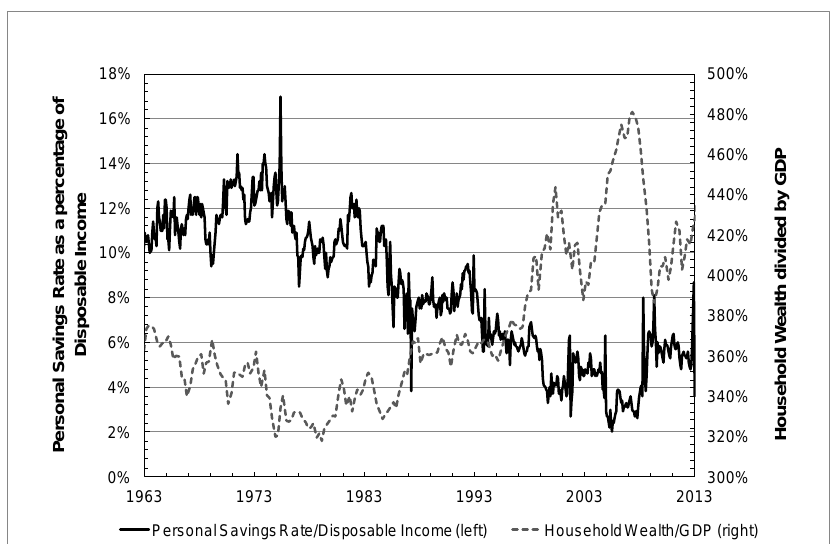
Figure 4. The U.S. Household Wealth divided by the GDP (right scale) [2] and the U.S. Personal Savings Rate as a percentage of the Disposable Income (left scale)